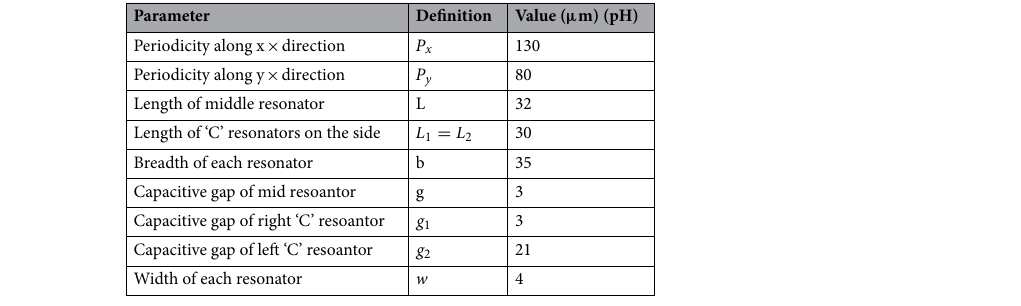
Table 1. Dimensional parameters of the MM unit